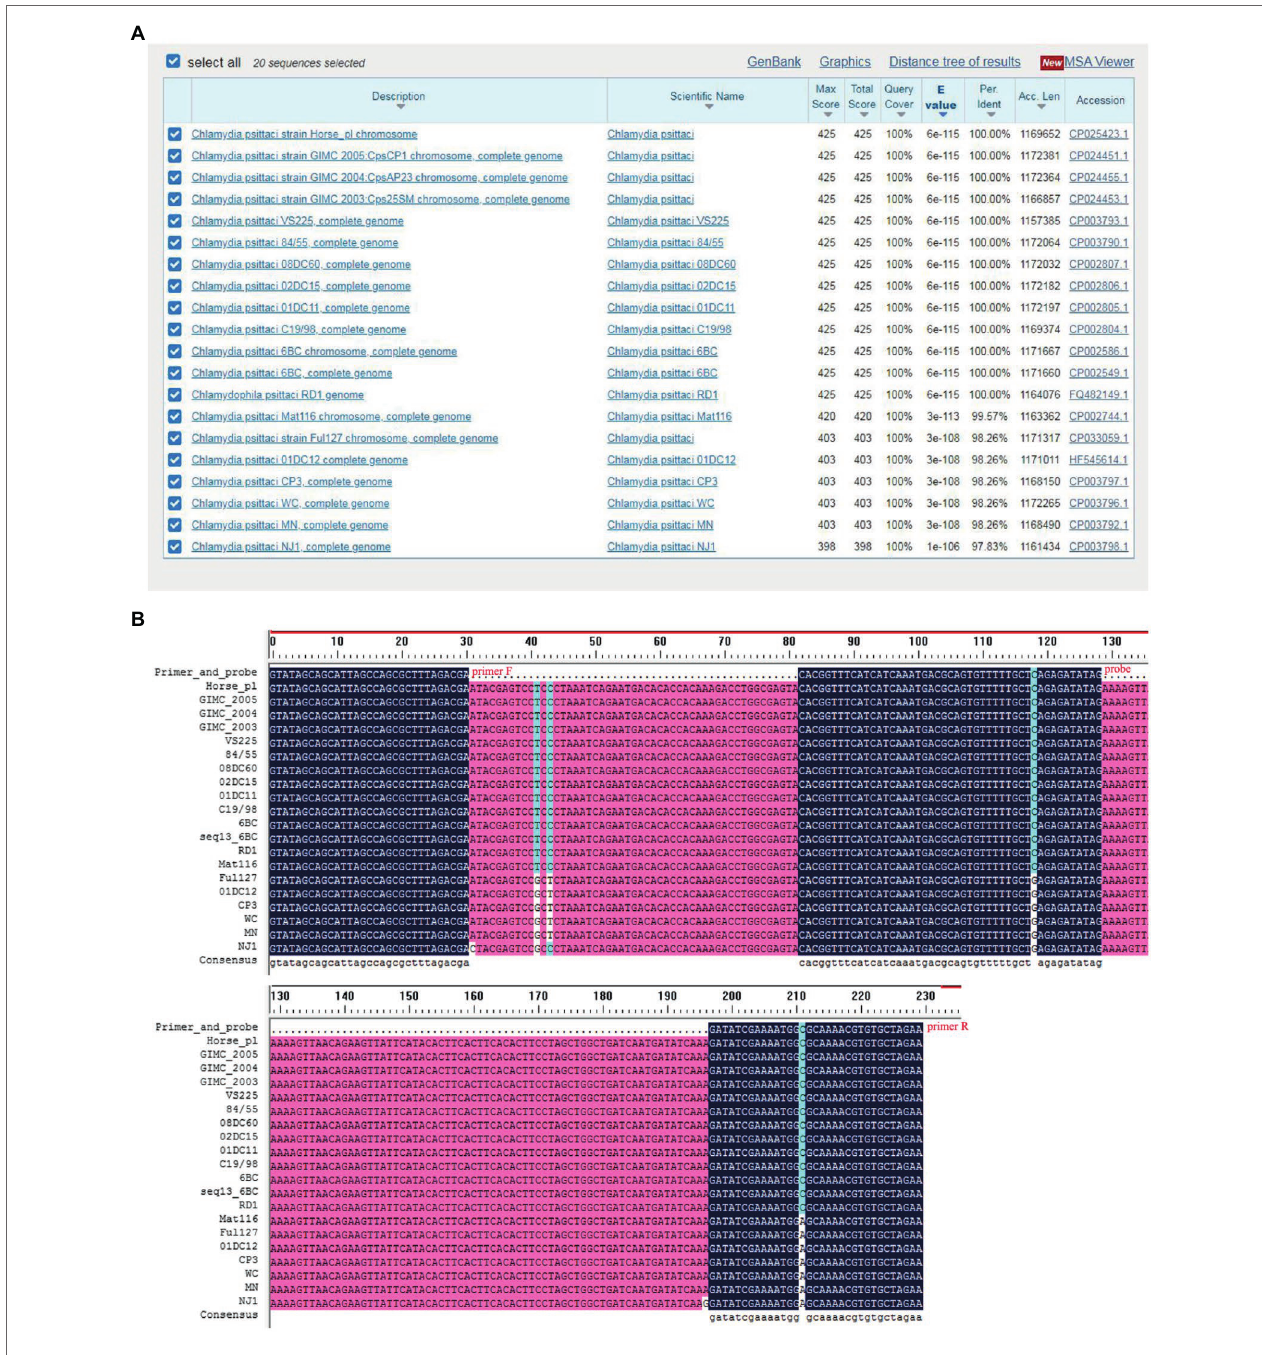
FIGURE 1 | Alignment of the conservation of the CPSIT_RS02830 gene. The conservative sequence of the CPSIT_RS02830 gene in Chlamydia psittaci was blasted against the National Center for Biotechnology Information nucleotide database (A) . The target sequences of the CPSIT_RS02830 gene was aligned between the forward and reverse primers among various C. psittaci strains (B)